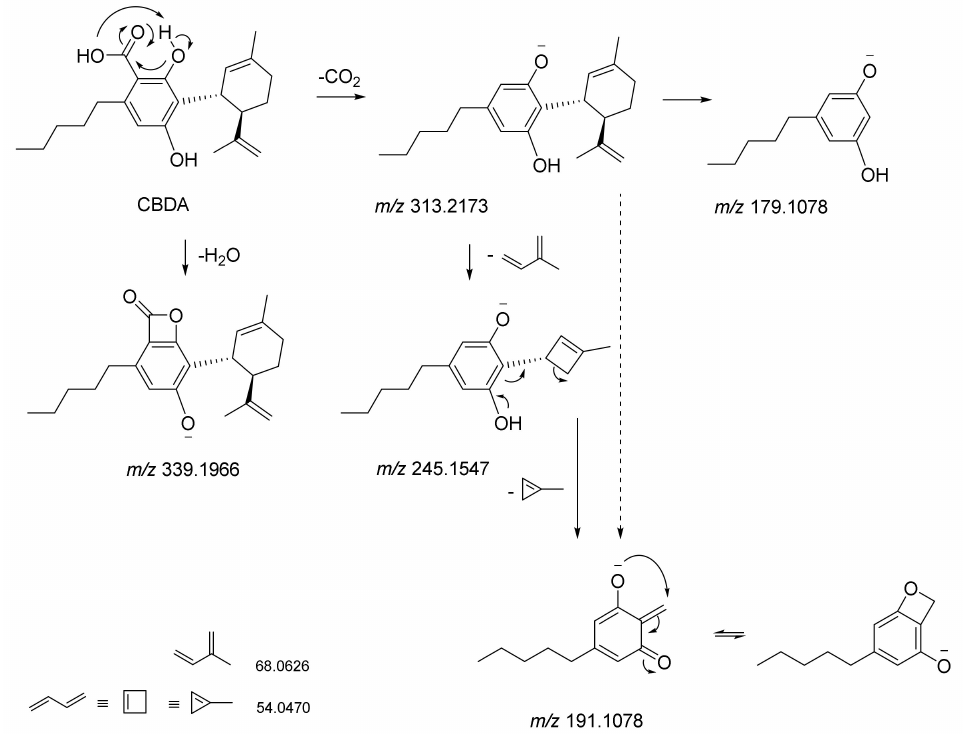
Figure 8. Proposed fragmentation pattern of CBDA compound based on TOF-MS / MS data.